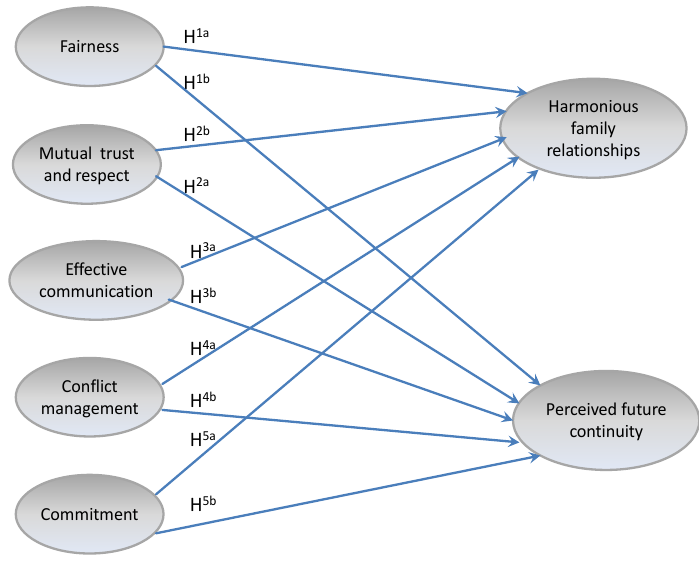
Figure 1: The hypothesised